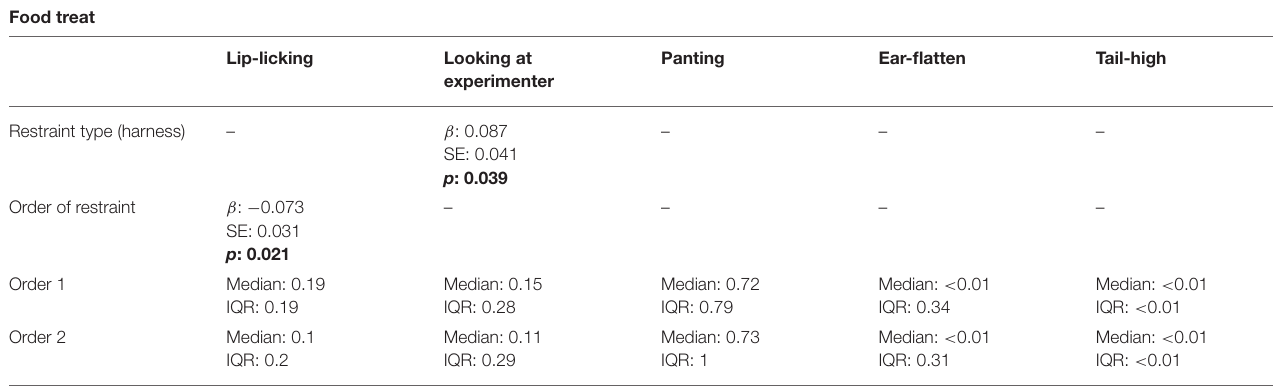
TABLE 5 | Linear mixed-effects model of the effects of restraint types and the order of restraint types used on canine behaviours when testing with food treats. Food treat Lip-licking Looking at Panting Ear-flatten experimenter